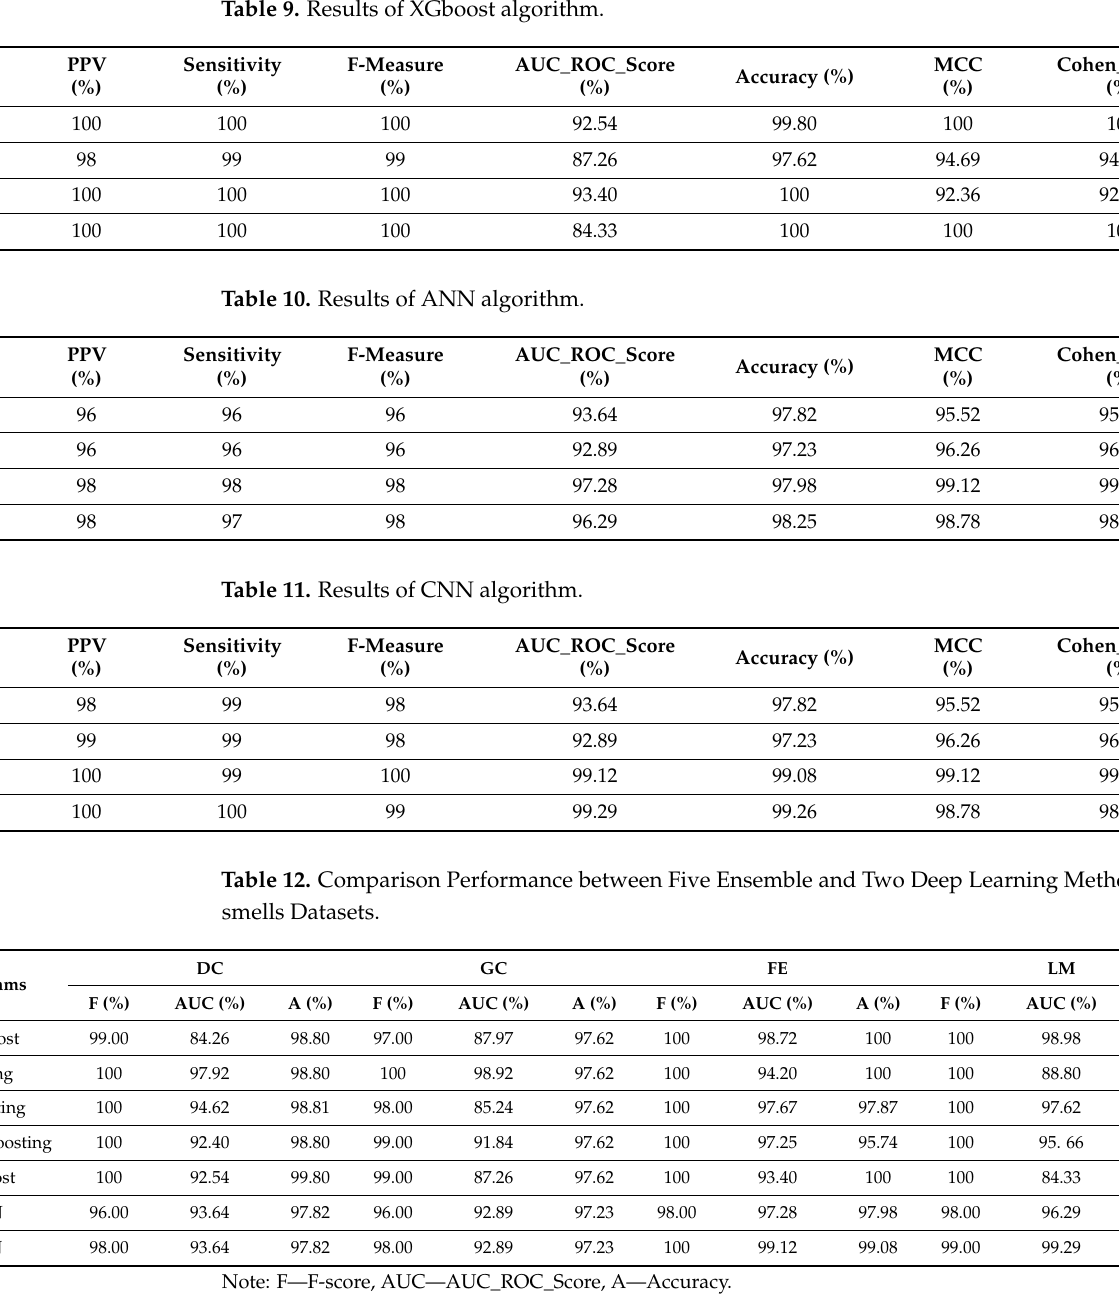
Table 9. Results of XGboost algorithm.